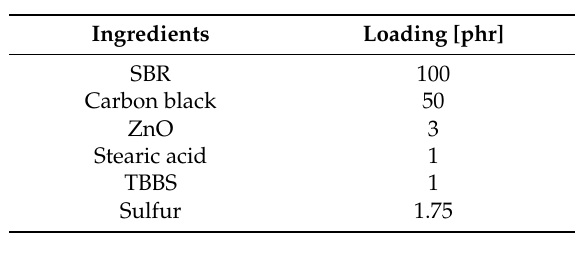
Table 1. Rubber compound recipe. SBR, styrene butadiene rubber; TBBS, N-tert-butyl-benzothiazole